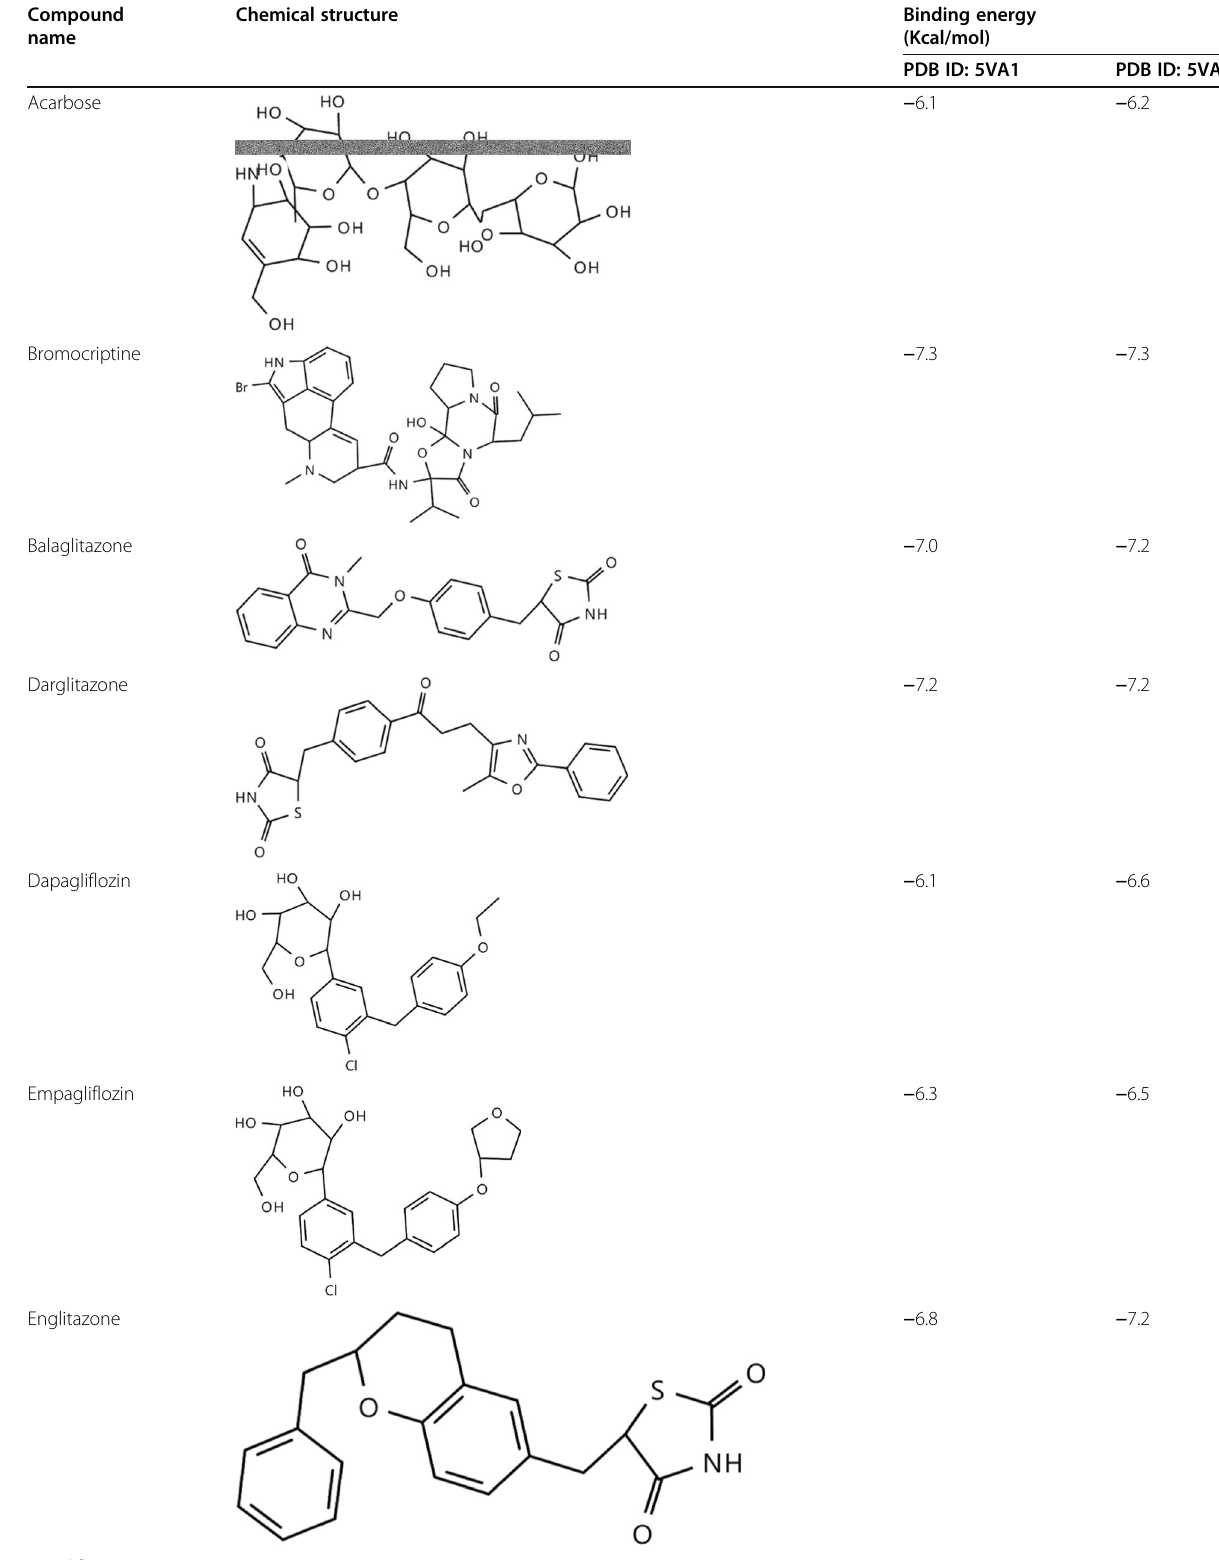
Table 2 The binding energies of the inhibitors with the two receptors (PDB IDs: 5VA1 and